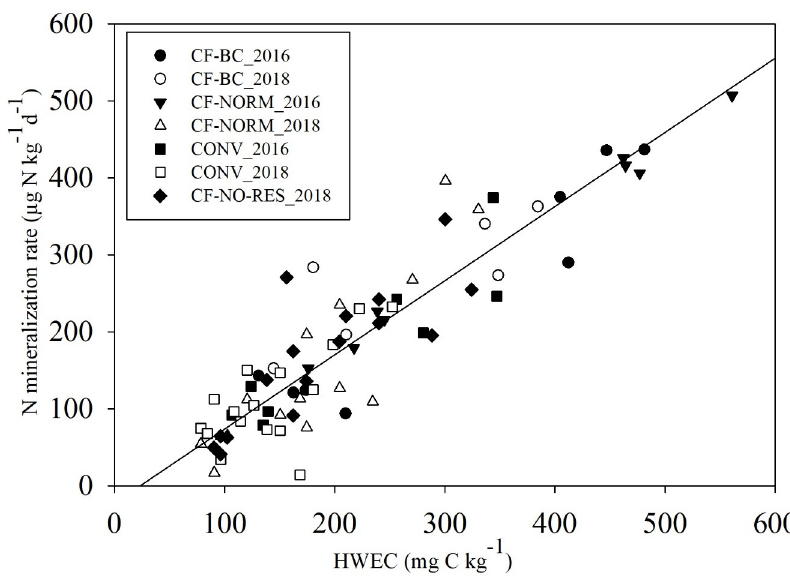
Fig 3. N mineralization rates and hot-water extractable C. Relationship between HWEC and potential N mineralization rates in CF-BC, CF-NORM, CF-NO-RES and CONV in the sampling campaigns of 2016 and 2018 [R 2 = 0.82; N min rate ( μ g-N kg soil -1 d -1 ) ~ 0.9622 x HWEC (mg C kg soil -1 )– 22.359].